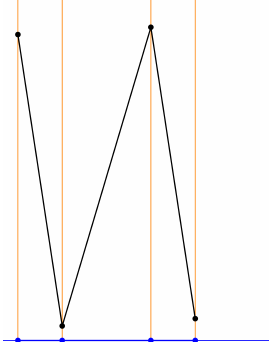
Figure 10. The ˆ σ 2 section for the p = 3 case. For this degenerate case, two pairs of the six 2 p members of Φ ( 3 ) coalesce, leaving four distinct points in the base space (blue dots). This results in those points having multiplier values that are twice that of the non-coalesced